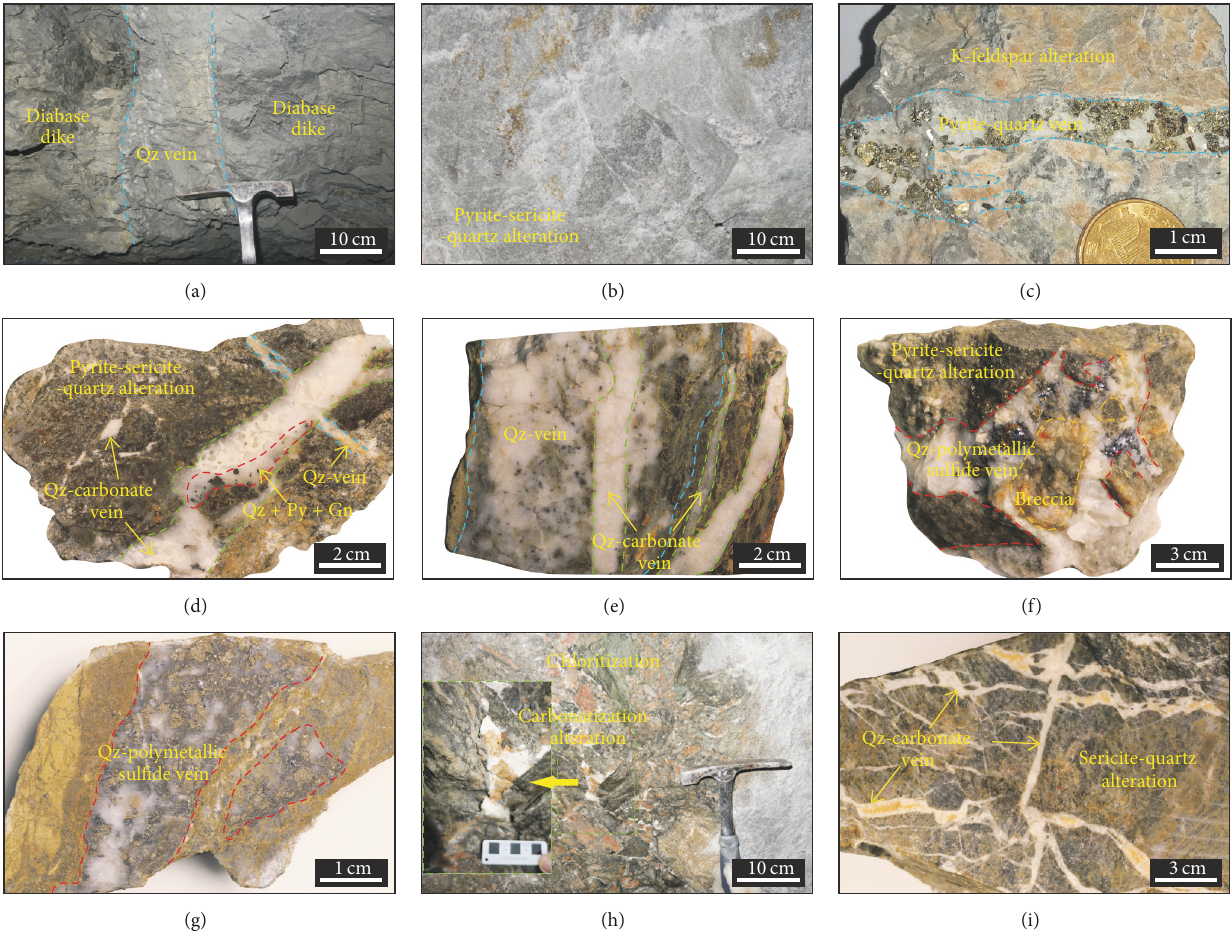
Figure 3: Photographs showing the mineral assemblages and cross-cutting relationships of different mineralization stage at the Liyuan gold deposit. (a) Early stage quartz vein cut a diabase dike. (b) Pyrite-sericite-quartz alteration in the early stage. (c) Early stage pyrite-quartz vein in association with K-feldspar alteration. (d) Early stage quartz vein cross cut by late stage quartz-carbonate vein, while the middle stage quartz-polymetallic vein was infilled by late stage quart-carbonate vein. (e) Early stage ore-barren quartz vein cemented by late stage quartz-carbonate vein. (f) Middle stage quartz-polymetallic vein occurring in pyrite-sericite-quartz alteration rock. (g) The Middle stage quartz-polymetallic vein. (h) The broken and brecciated pyrite-sericite-quartz rock and chlorite-altered rock fulfilled by late stage carbonate. (i) Late stage quartz-carbonate veinlets filling the extension joints in sericite-quartz alteration